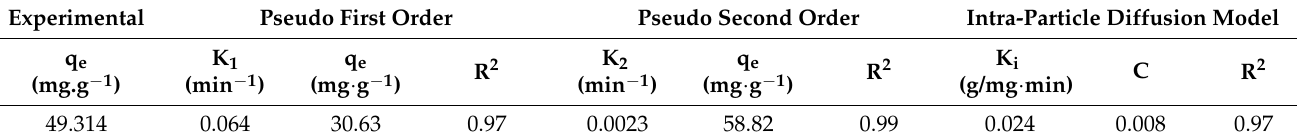
Table 2. Kinetic parameter of the adsorption of Cr (VI) on the surface of (MNPs-AC), pH 2, adsorbent dose 100 mg, and vortex time 35 min.